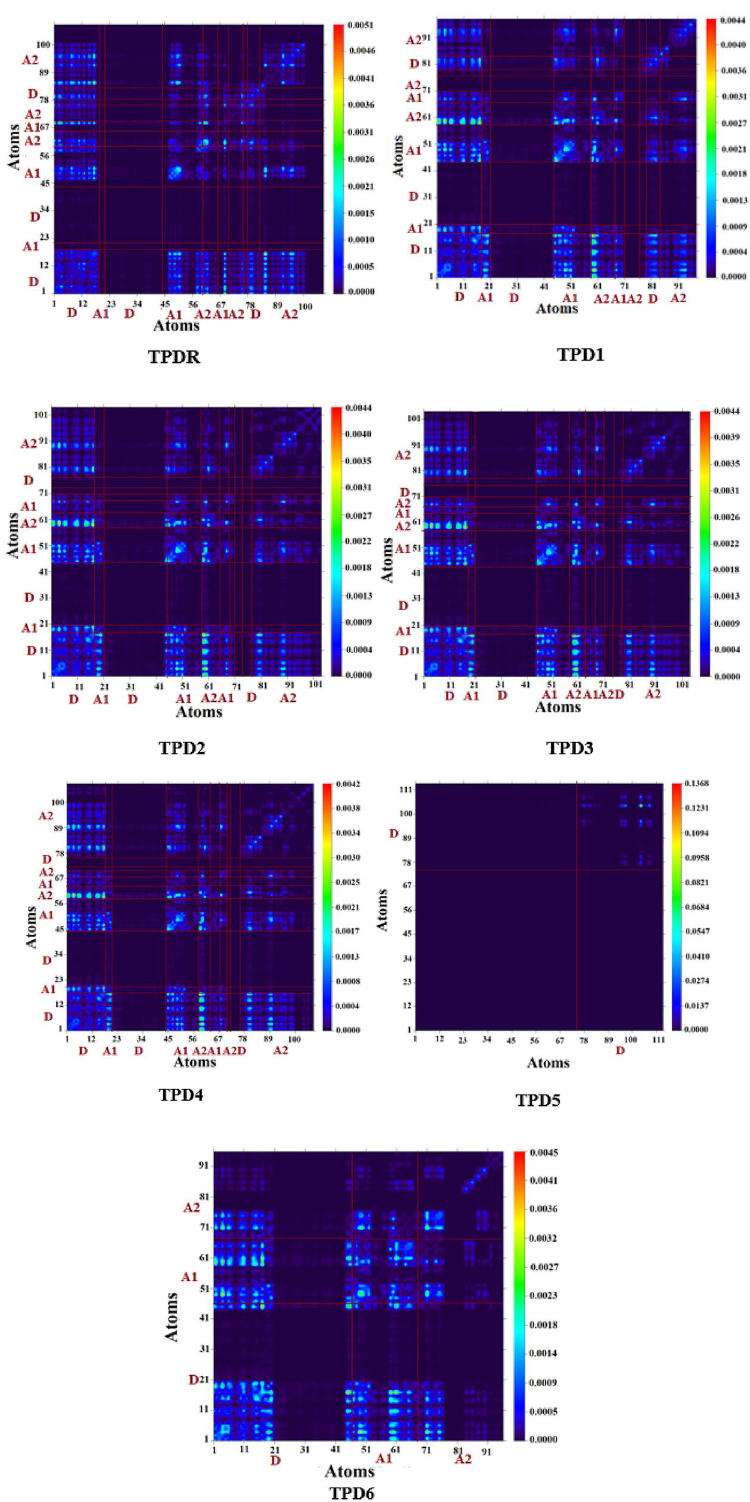
Figure 9. TDM of studied compounds at the S1 state. These were drawn with the help of Multiwfn 3.7software (http:// sober eva. com/ multi wfn/). All out put files of designed compounds were accomplished by Gaussian 09 version D.01 (https:// gauss ian. com/ g09ci